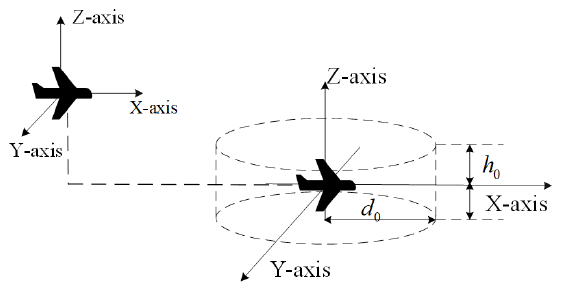
Figure 2. Relative position relationship between aircrafts.